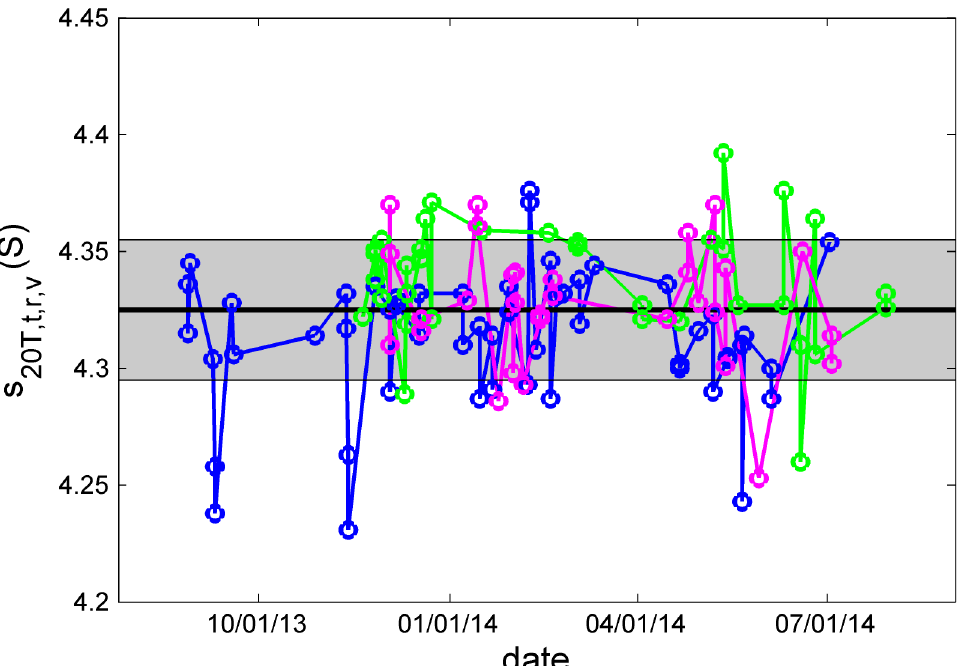
Fig 1. Absence of a long-term trend in s 20T , t , r , v -values of the BSA monomer with time of experiment for the three kits (blue, green, and magenta). Highlighted as bold solid line is the overall average, and the grey area indicates one standard deviation.